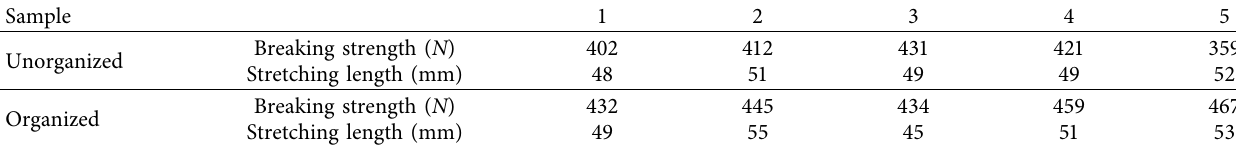
Figure 6: Drapability of fabric. Table 6: Reaction fabric strength.